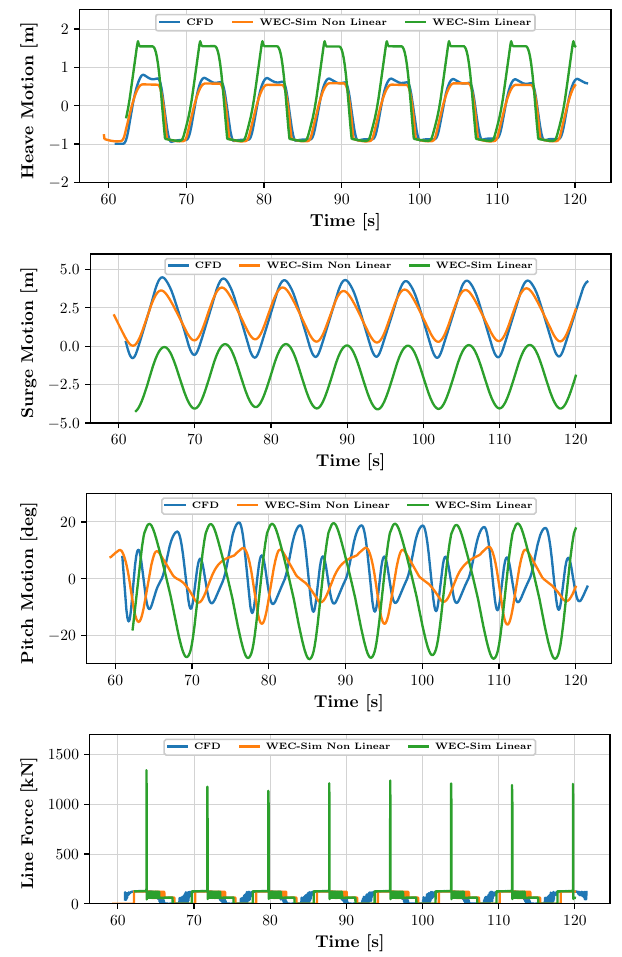
Fig. 13. The WEC is allowed to move in 3 DoF. The WEC-Sim model utilizes the linear and the weakly nonlinear approach for the calculation of the hydrostatic restoring and Froude-Krylov forces. The results are compared with the CFD solution, showing the importance of including the nonlinear effects.